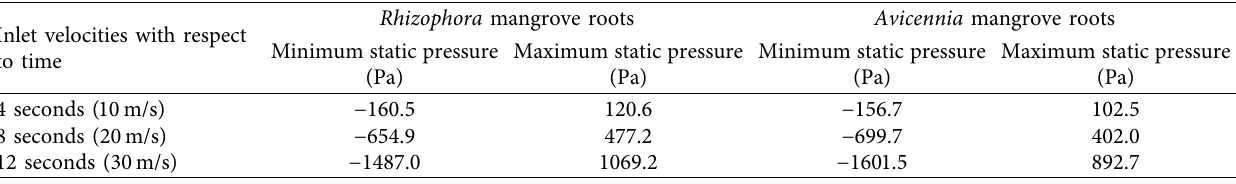
Table 6: The minimum and maximum static pressure of flow around Rhizophora and Avicennia mangrove roots at time intervals of 4 seconds, 8 seconds, and 12